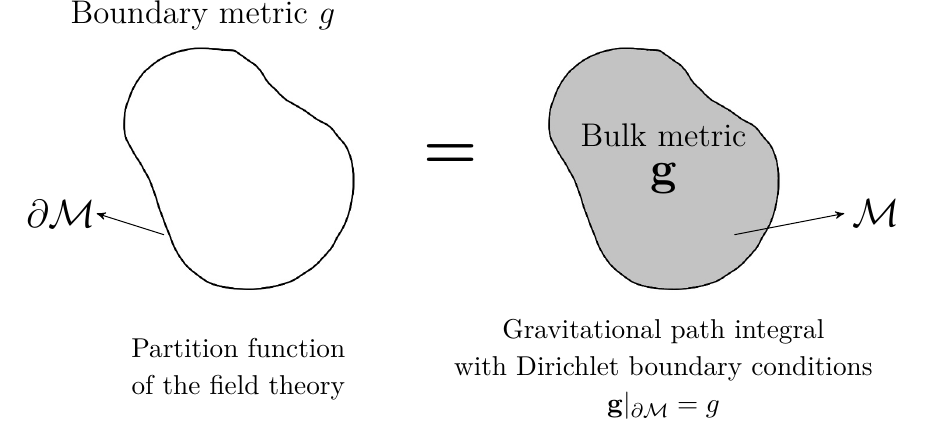
Figure 3 . The figure on the left represents the partition function of the T 2 -deformed field theory living on ∂ M (the closed curve) with a background metric g . The shaded figure on the right represents the gravitational path integral over the space filling manifold M . The bulk metric g satisfies the Dirichlet boundary conditions (i.e g | = g ) ∂ M